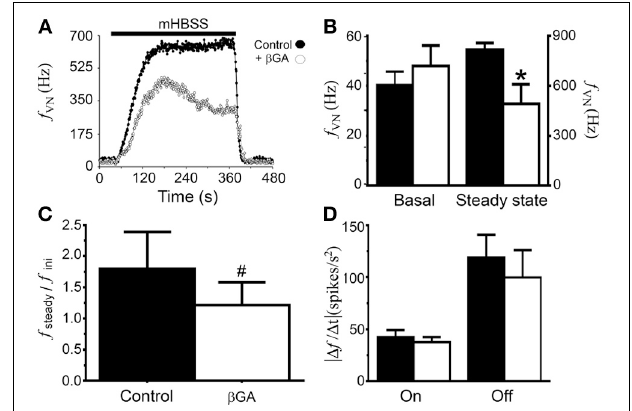
FIGURE 5 | The enhanced neuronal activity induced by mHBSS is sensitive to β GA. (A) Rat NPJcs were placed in a recording chamber superfused with Hanks’ solution (HBSS), followed by superfusion with mHBSS alone (filled circles) or supplemented with 70 μ M β GA (empty circles). Bar over the response indicates superfusion with mHBSS. (B) Graph showing the average of the basal (pre-stimulus) and steady-state (last 30s of the response) frequency of discharge in the absence (filled bar) or presence (empty bar) of β GA in the superfusion medium ( n = 6). (C) Graph showing the ratio between the mean steady-state frequency of discharge and mean initial frequency (2min average after 1min of the beginning of the stimulation) for each condition. (D) Calculated absolute values for the increase and decrease rates of the discharge frequency in the absence (filled bar) or presence (empty bar) of β GA in the superfusion solution. ON represents the rise in frequency when the NPJc is superfused with mHBSS and OFF is the decrease in the frequency of discharge when the ganglion is re-superfused with HBSS. Statistical significances; P < 0 . 05 with respect to control (mHBSS) condition. # Wilcoxon matched-pairs signed rank test; ∗ Student’s paired t -test. Deviation marks: